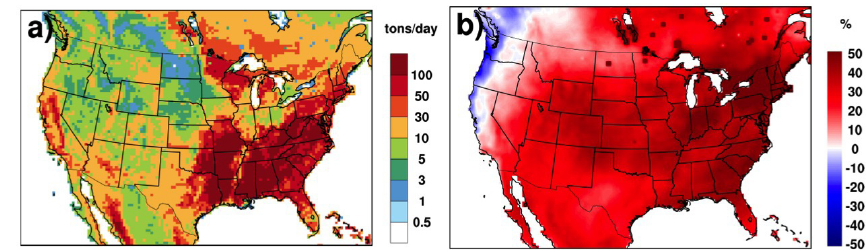
Figure 10. (a) Current decade summertime isoprene emissions, and (b) percent change induced by climate on future summertime isoprene emissions with current decade land use.